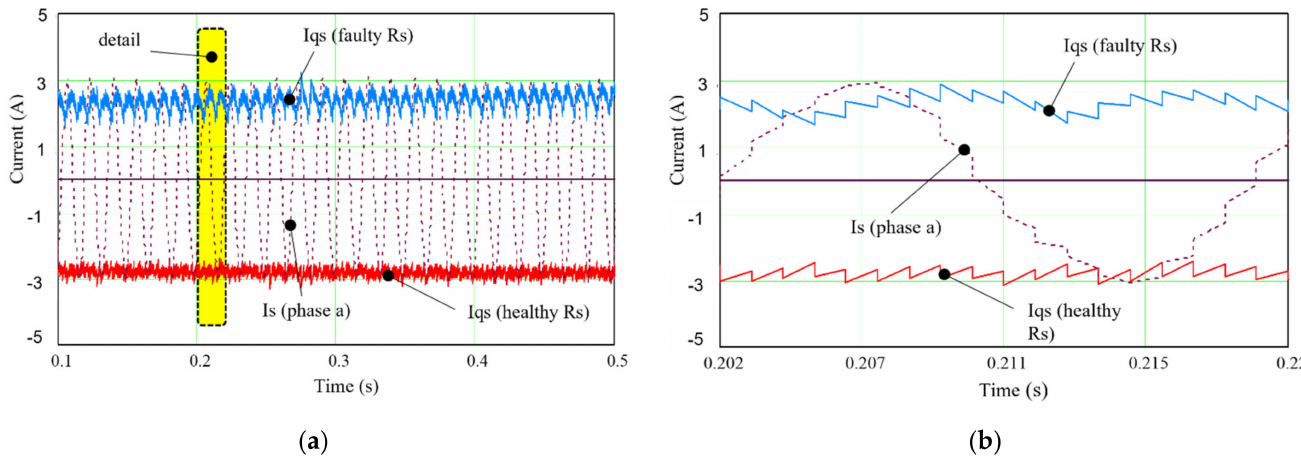
Figure 8. Measurement of current I qs in fault-free and under-fault condition: ( a ) I qs with healthy and faulty R s , ( b ) details of I qs .